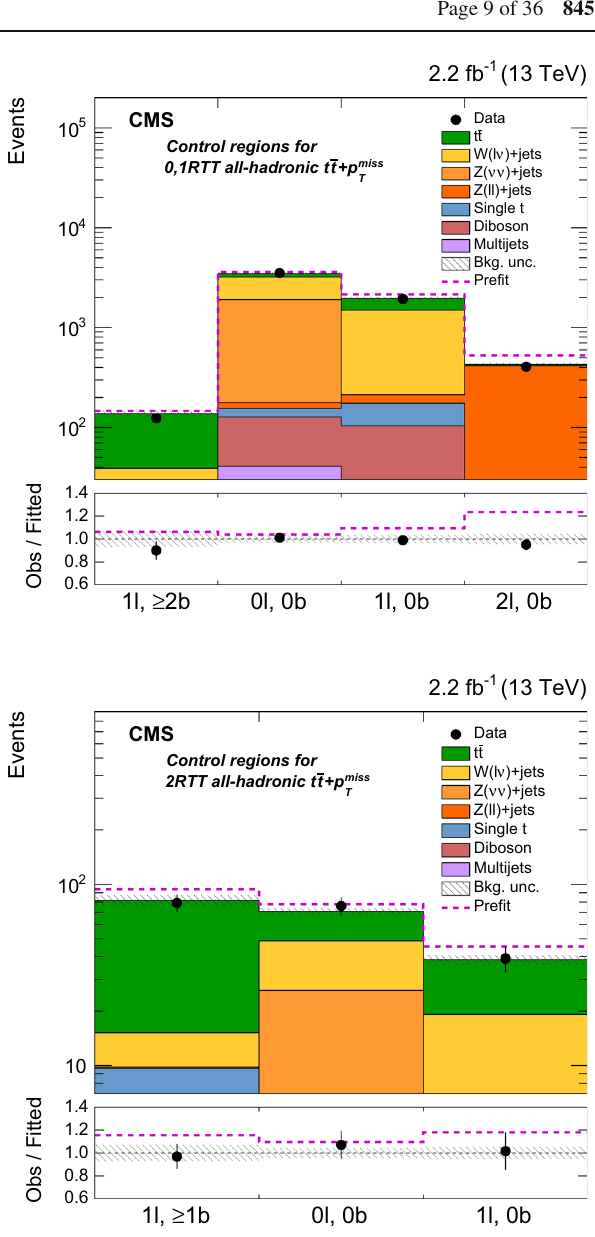
Fig. 5 Observed data, and prefit and fitted background-only event yields in the control regions associated with the 0,1 RTT (upper) and 2 RTT (lower) all-hadronic tt + p miss signal regions. The 1 lepton, ≥ 2 b T tag control region (hadA in Table 2) constrains (cid:5) + jets tt background in the 0,1 RTT signal region. This process is constrained in the 2 RTT signal region using the 1 lepton, ≥ 1 b tag control region (hadE). The ≤ 1 lepton, 0 b tag control regions (hadB, hadC, hadF, hadG) constrain W + jets and Z + jets backgrounds, while the 2 lepton, 0 b tag control region (hadD) provides an additional constraint on the Z + jets back- ground. The lower panels show the ratios of observed to fitted back- ground yields. In both panels, the statistical uncertainties of the data are indicatedasverticalerrorbarsandthefituncertaintiesashatchedbands. Prefit yields and the ratios of prefit to fitted background expectations are shown as dashed magenta histograms the lepton is not identified. Control regions for (cid:5) + jets tt (hadA, hadE) are defined by selecting events with